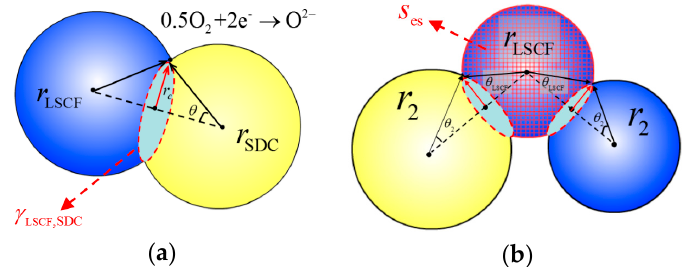
Figure 2. ( a ) Sketch of electrochemical reaction site per contact between LSCF- and SDC-particles γ LSCF,SDC ; ( b ) illustrated of the exposed surface area of per LSCF-particle s es LSCF ,SDC